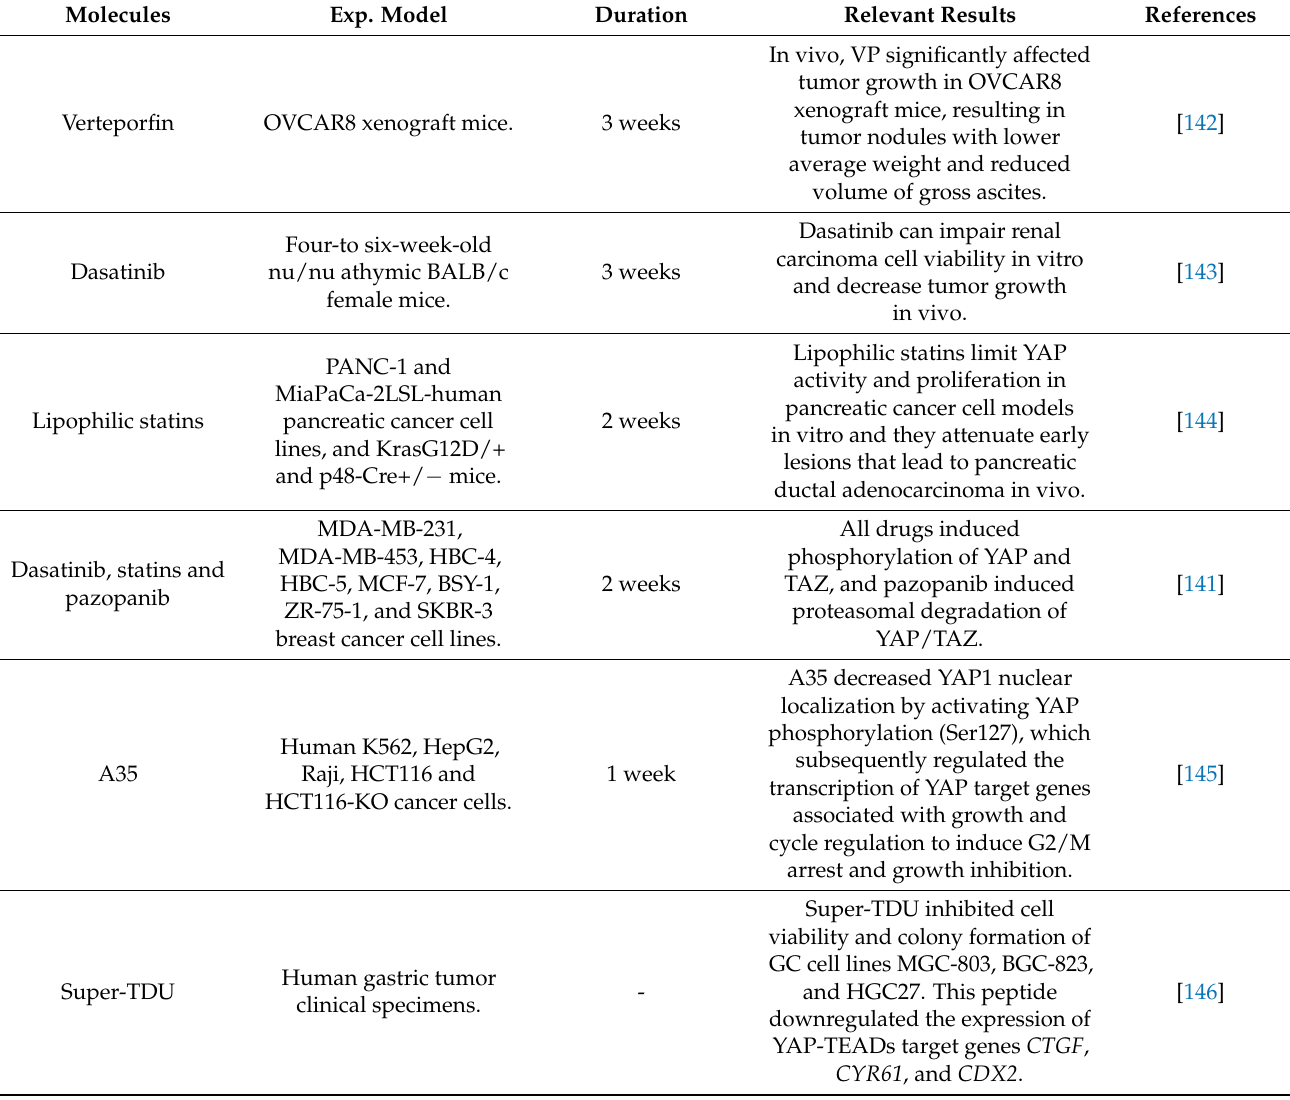
Table 1. Molecules targeting YAP/TAZ in cancer therapy-preclinical